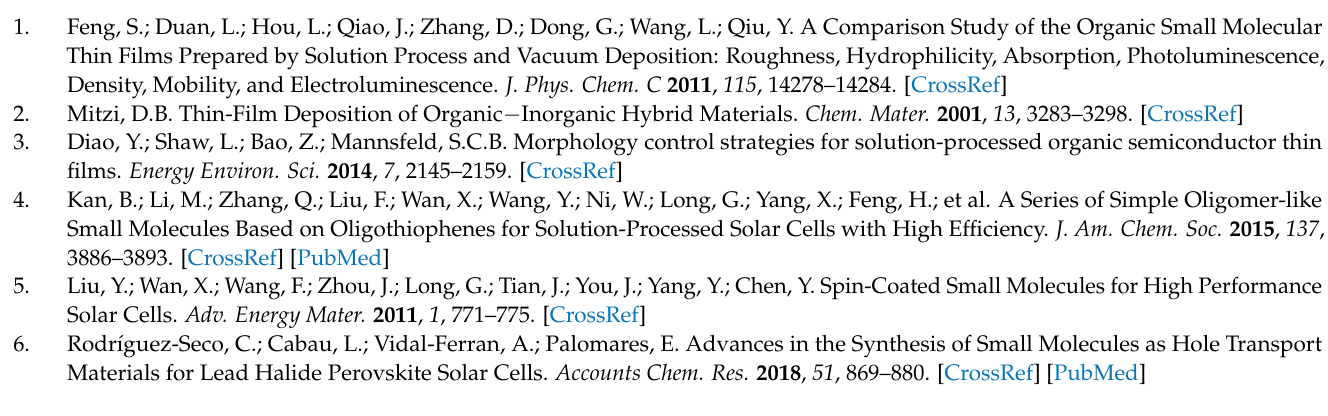
chlorobenzene and DMF at different temperatures; Figure S7: Representative AFM images of deposits obtained whit compound IV for acetonitrile and methanol at different